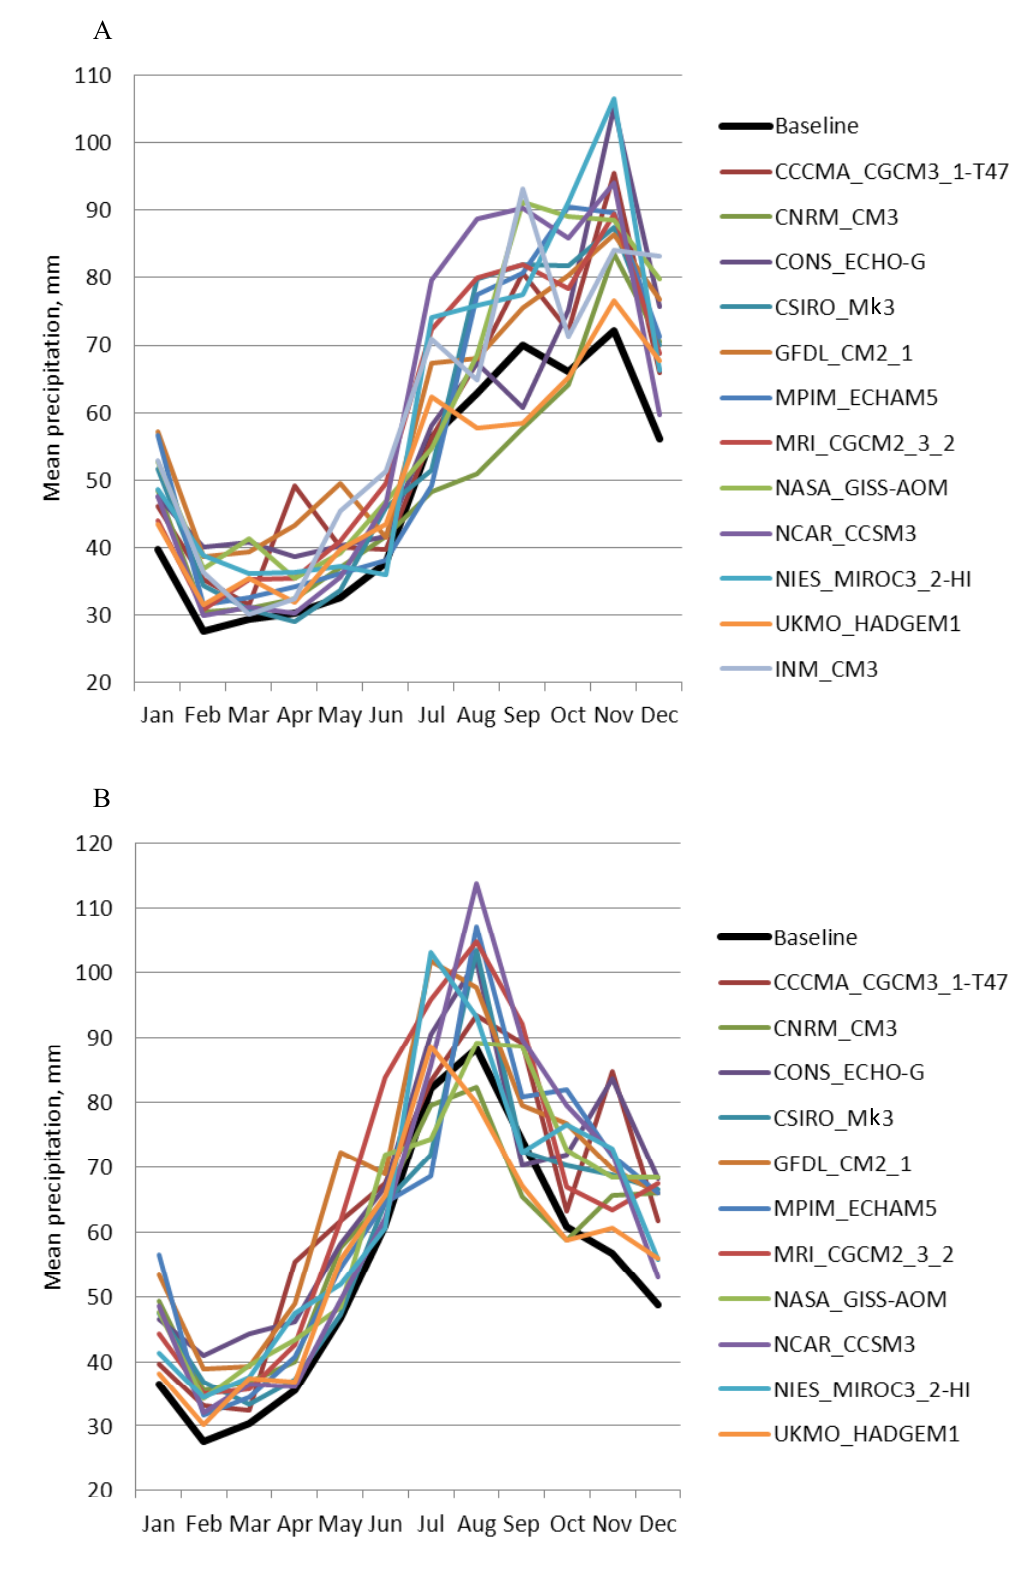
Fig. 7. Annual curve of monthly mean precipitation in western ( A ) and eastern ( B ) Estonia observed in 1961(cid:150)1990 (baseline) and modelled for 2070(cid:150)2099 using the A1B emission scenario and 12 GCM outputs from